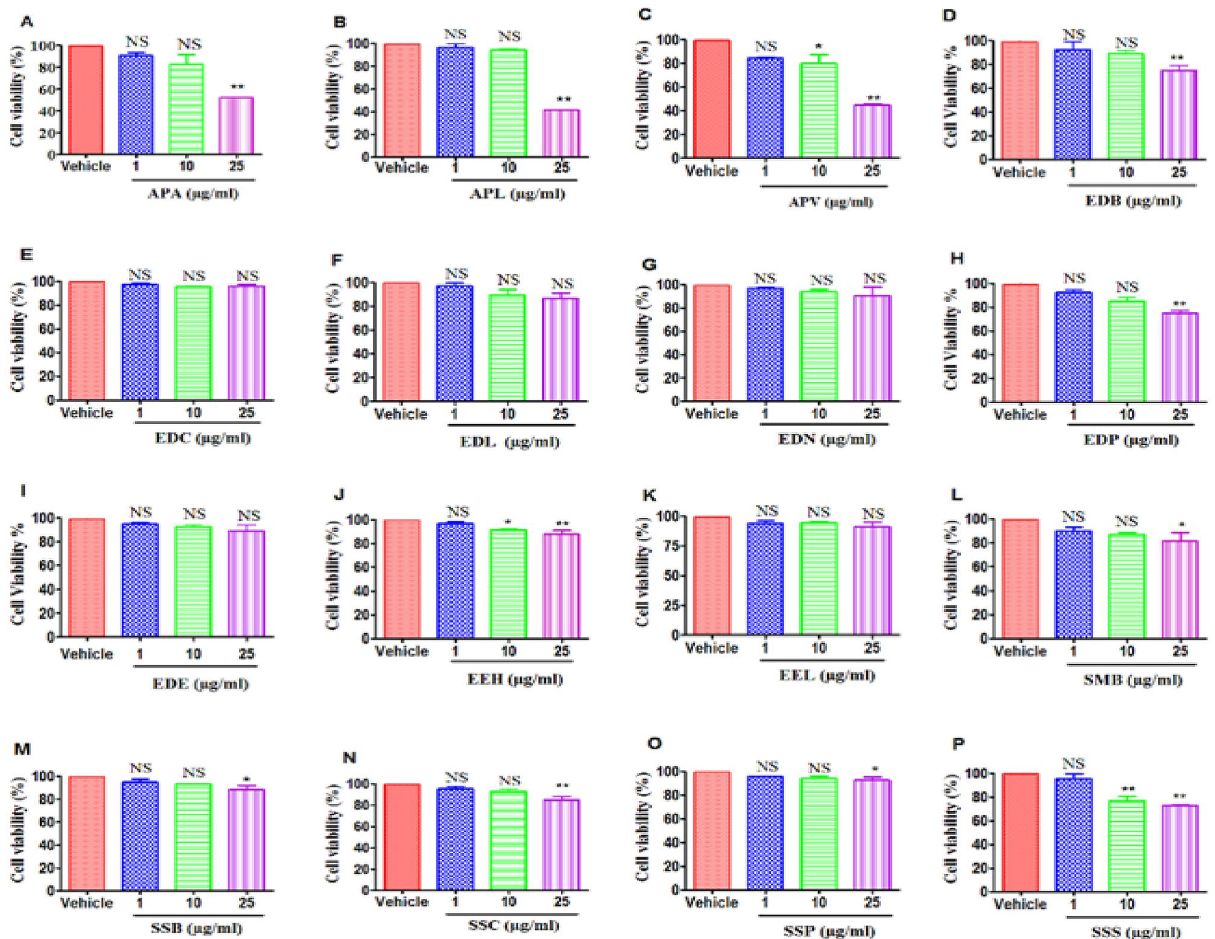
Figure 2. Effect of treatment of EL-4 cells with plant extracts on cell viability: EL-4 cells were cultured with various plant extracts or DMSO as vehicle, for 24 h. The cell viability was next measured by using the MTT test. ( A – C ) represent the Asteraceae family (( A ) APA, ( B ) APL, ( C ) APV). ( D – I ) represent the Ebenaceae family (( D ) EDB, ( E ) EDC, ( F ) EDL, ( G ) EDN, ( H ) EDP, ( I ) EDE). ( J – K ) represent the Erythroxylaceae family (J: EEH, K: EEL). L-P represent the Sapotaceae family (( L ) SMB, ( M ) SSB, ( N ) SSC, ( O ) SSP, ( P ) SSS). The vertical bars represent mean ± S.E.M. of three independent experiments. The significance between various groups was tested using one-way ANOVA where NS: Not significant; (*)p < 0.05, (**)p < 0.01, (***)p <